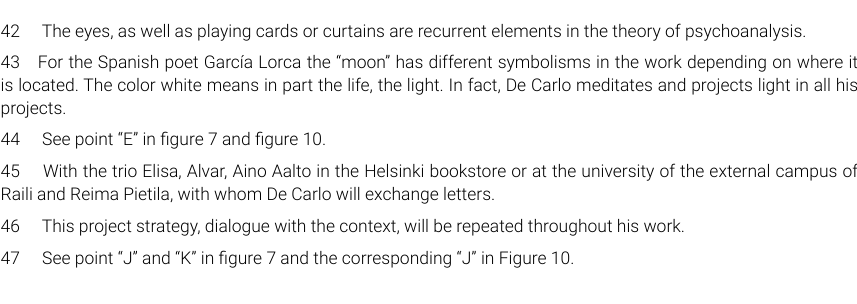
Fig. 8 Detail of the skylight. Source: Università Iuav di Venezia, Archivio Progetti, fondo Giancarlo De